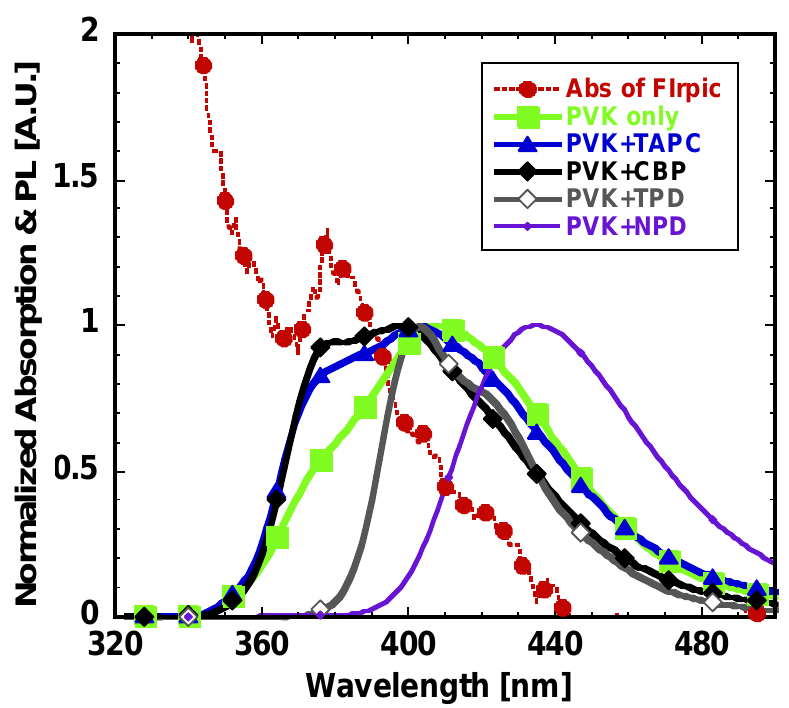
Figure 7. Normalized absorption spectrum of FIrpic blue triplet emitter and photoluminescent (PL) emission spectra of polymeric host layers. emission spectra of polymeric host